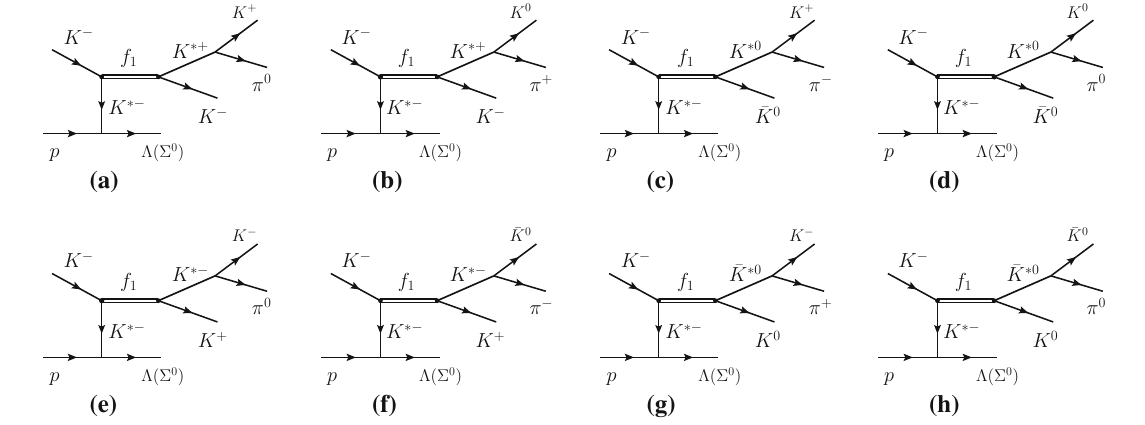
Fig. 1 The mechanism for K − p → (cid:4)((cid:3) 0 ) f 1 → (cid:4)((cid:3) 0 ) K π ¯ K